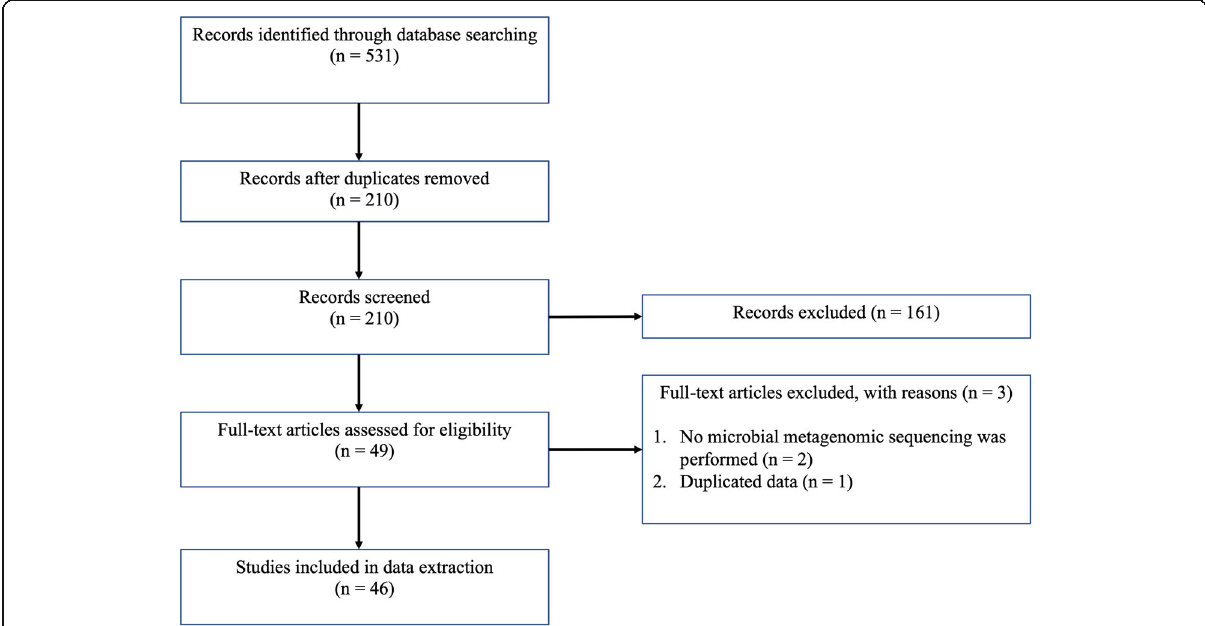
Fig. 1 Flow chart of systematic review. The steps were adopted and modified from the Preferred Reporting Items for Systematic Reviews and Meta-Analyses (PRISMA)